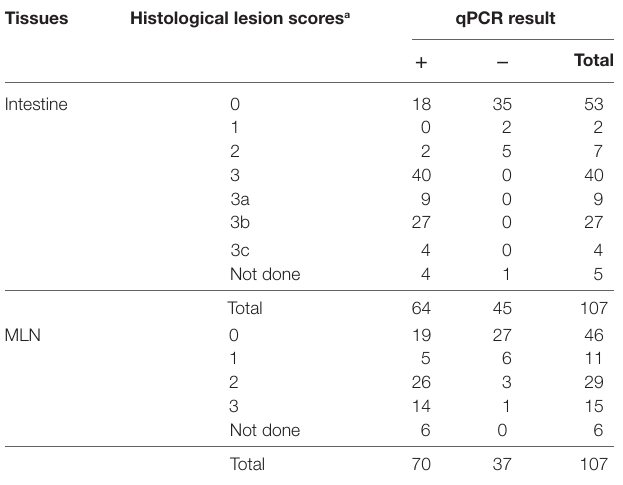
TaBle 3 | Comparison of the test result (cutoff ≥ 0.0005 pg) of intestine and mesenteric lymph node (MLN) quantitative PCR (qPCR) corresponding to various grades of lesion scores on histopathological examination.